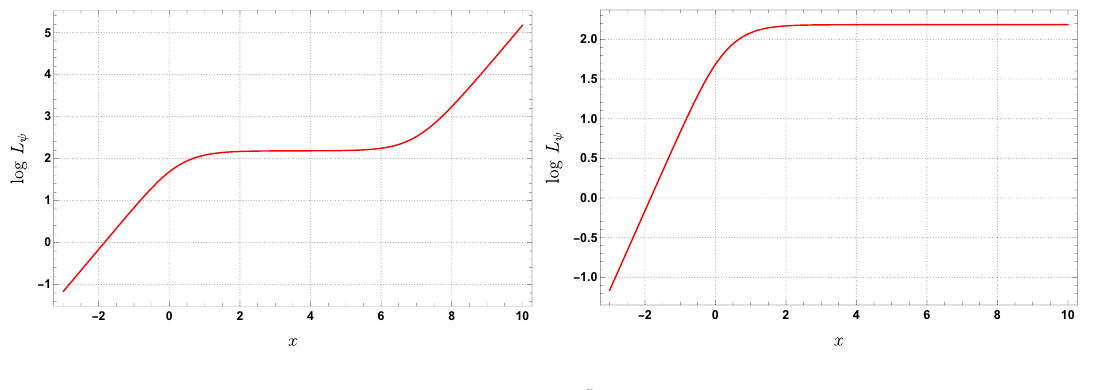
. In the first graph we have taken σ = 2 , e 2 x +1 regions 3 region is not 3